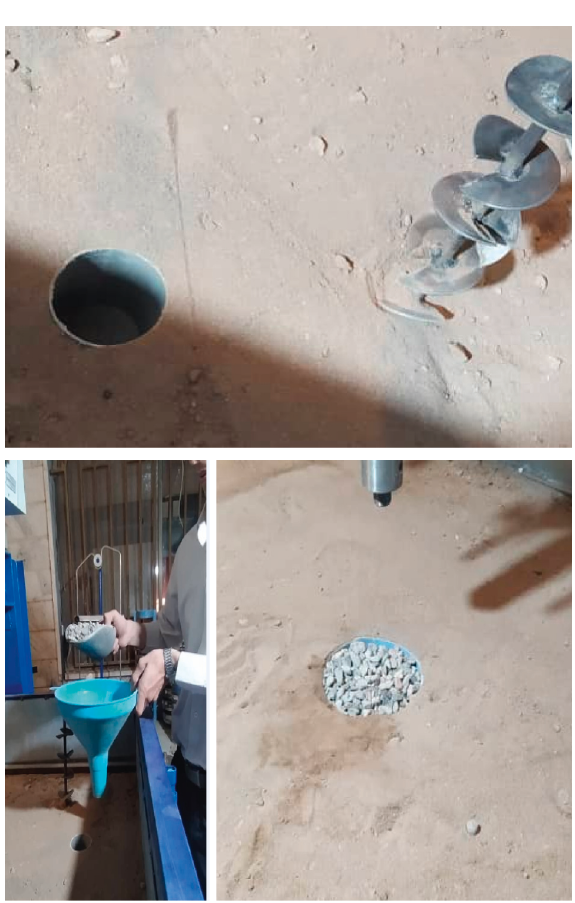
Figure 5: Steps of making a stone column in the laboratory.